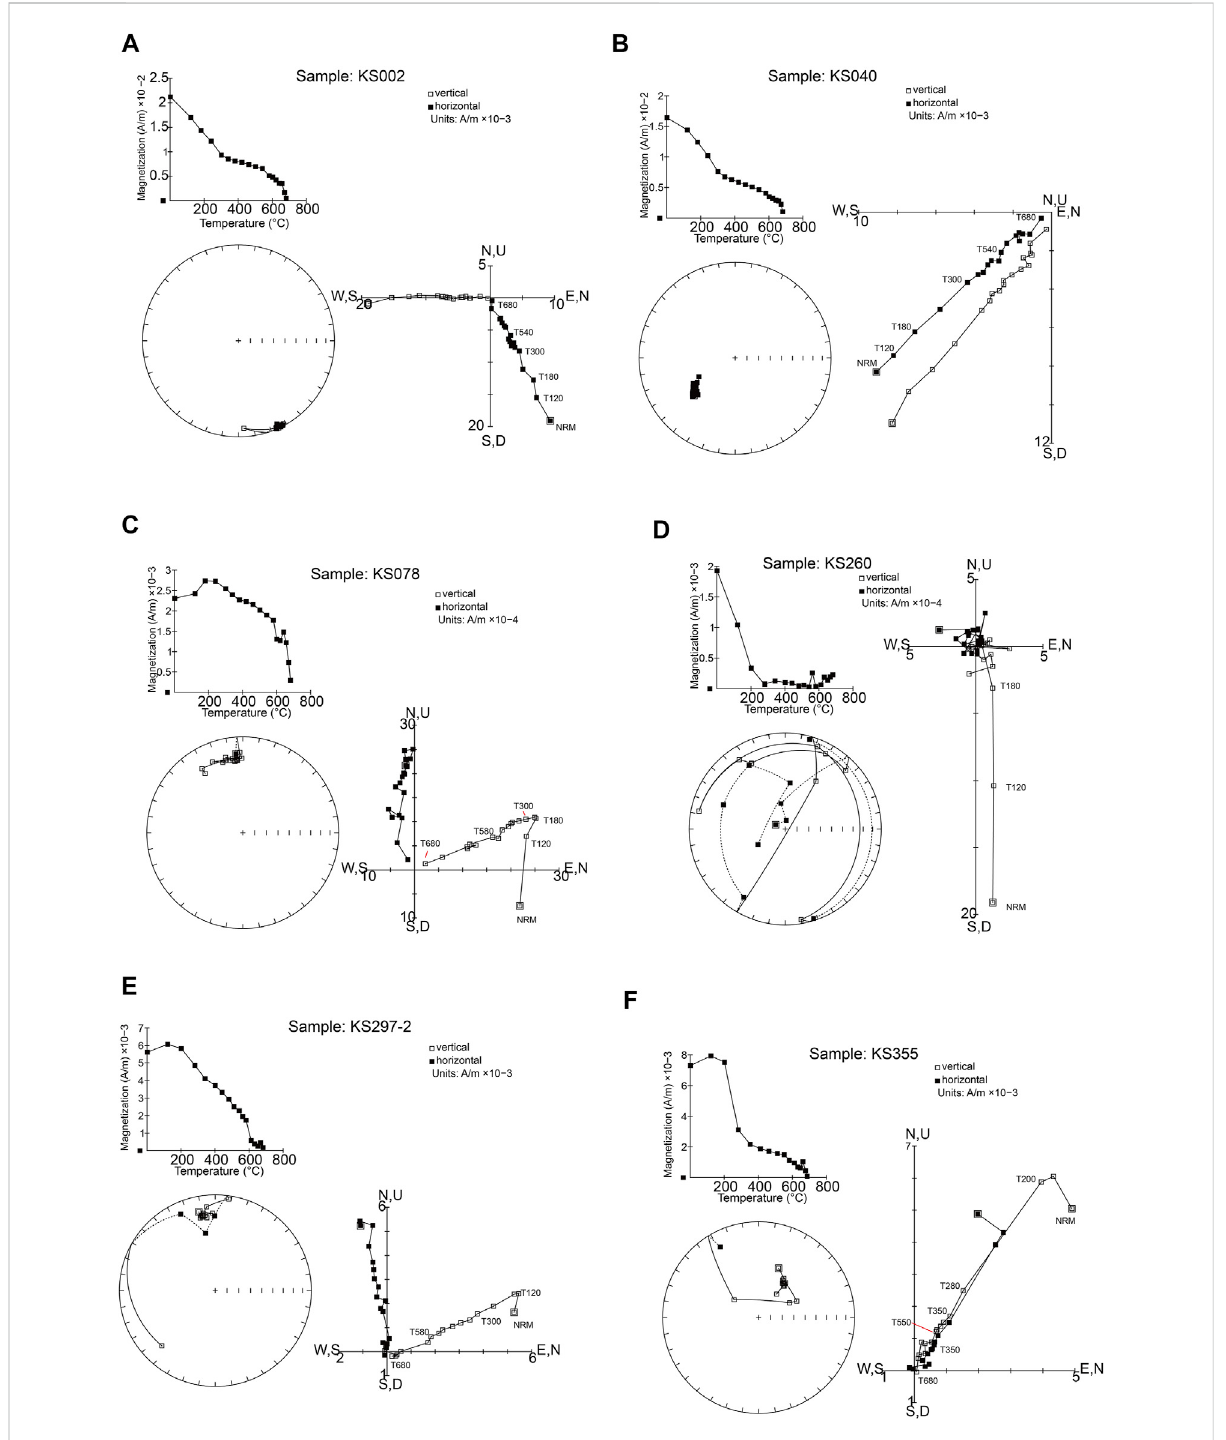
FIGURE 5 Zijderveld vector diagrams and Equal-area plots for representative specimens. (A) Sample: KS002, (B) Sample: KS040, (C) Sample: KS078, (D) Sample: KS260, (E) Sample: KS297-2, (F) Sample: